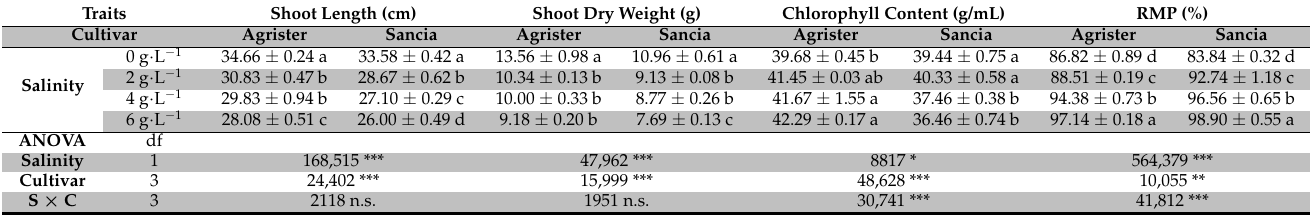
Table 1. Physiological changes in the maize cultivars Agrister and Sancia under salt stress; analysis of shoot length, biomass, chlorophyll content, and relative membrane